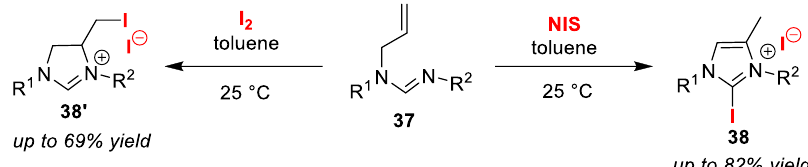
Figure 19. The selective synthesis of cyclic formamidinium salts 38 and 3 8′ via iodo-amino-cyclization of N -alkenyl formamidines 37 using iodine reagents.